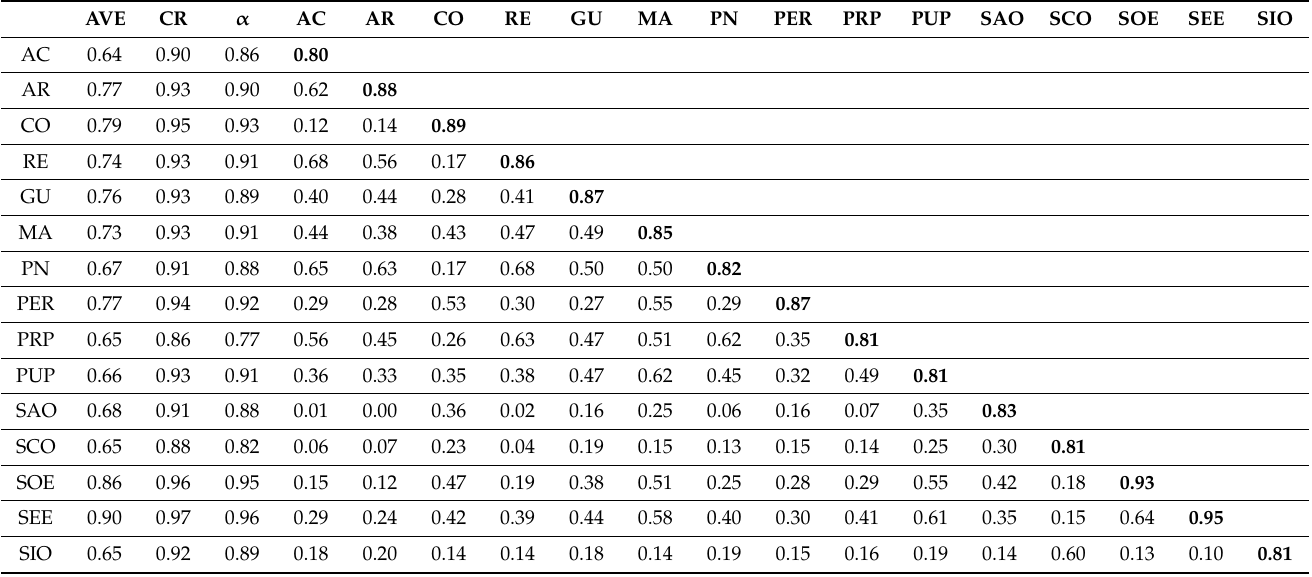
Table 1. Correlations among constructs and the square root of the